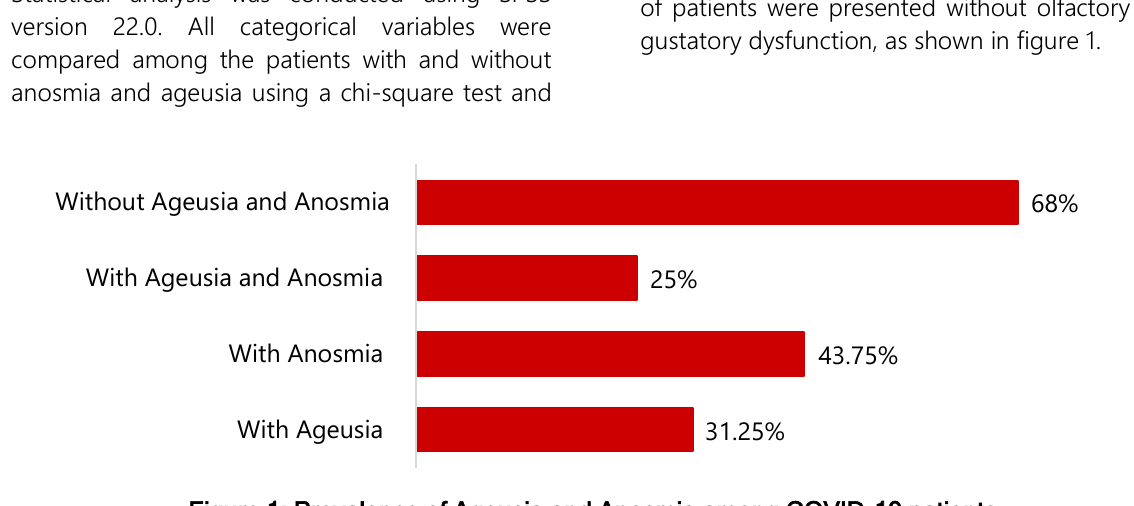
Figure 1: Prevalence of Ageusia and Anosmia among COVID-19 patients.